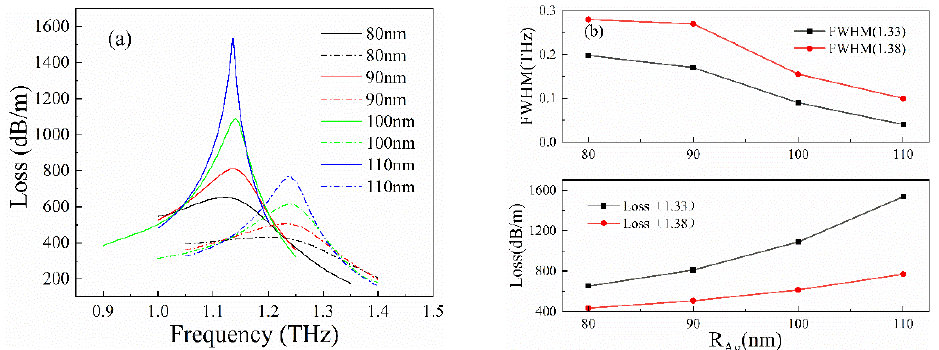
Figure 3. ( a ) Loss peak curves of different R Ag . ( b ) FWHM and loss of different R Ag .